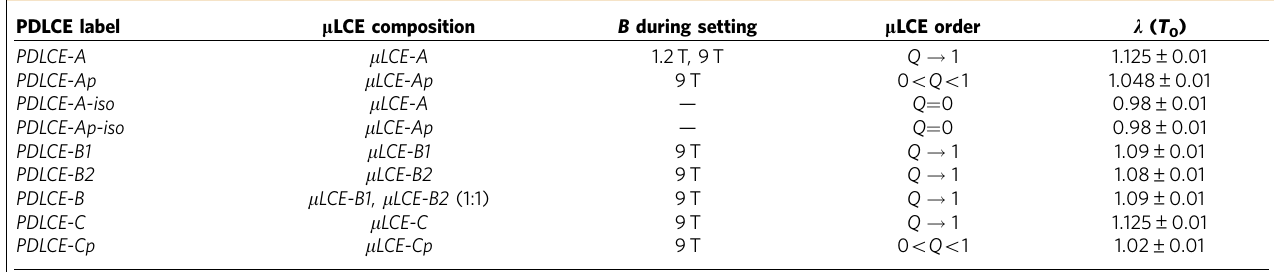
Table 2 | List of PDLCE composition and performance. PDLCE label